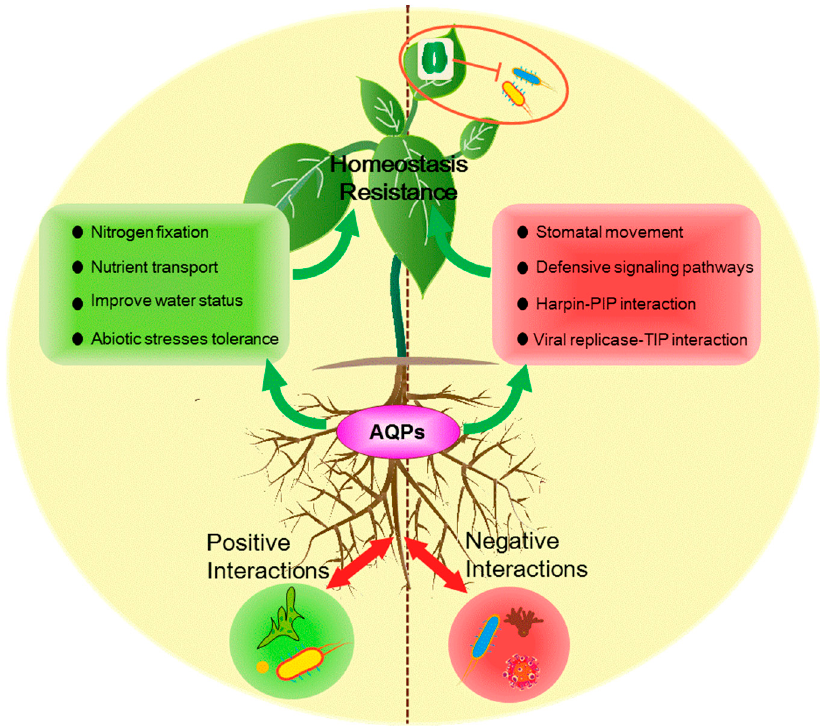
Figure 4. AQPs’ currently established positive roles in different pathways on plants in both positive and negative plant–microbe interactions. For positive plant–microbe interactions, AQPs mainly transport water and other physiological substances to maintain relative water content and leaf water potential by regulating specific AQP gene expression and activity under specific growth conditions. For negative plant–microbe interactions, AQPs use signaling in guard cells to adjust stomata and can interact with pathogen effectors or replicase, and can also induce resistance of plants by H 2 O 2 signaling.